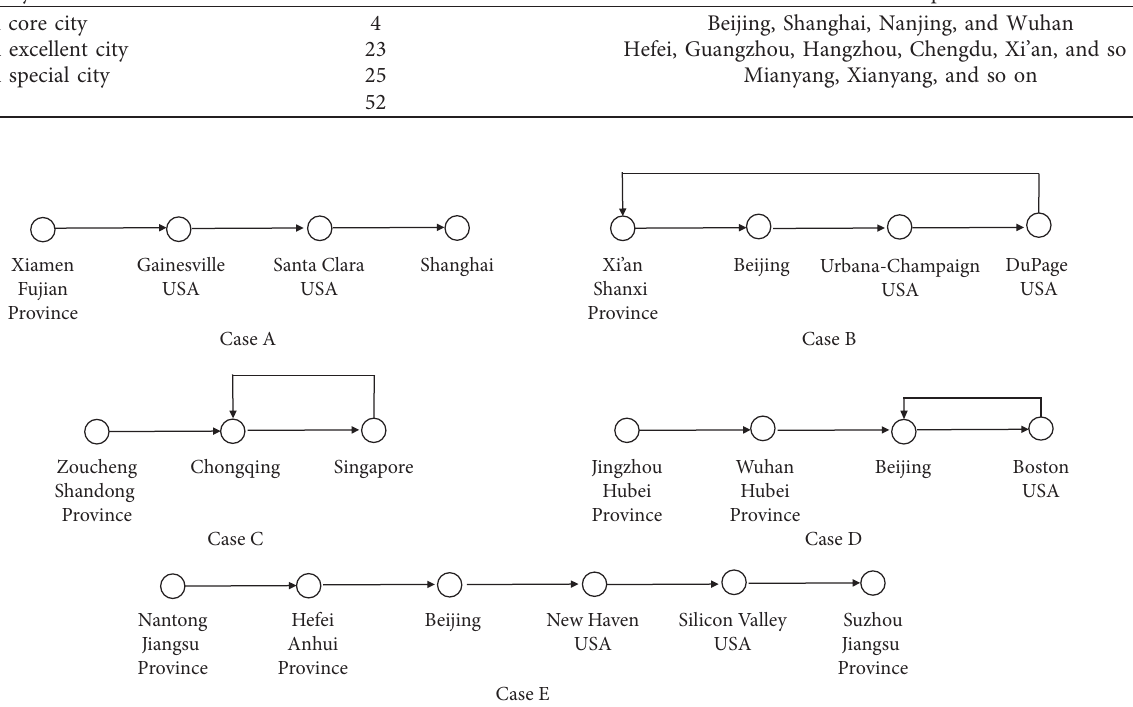
Figure 3: Backflow character formed by the migration tracks of five